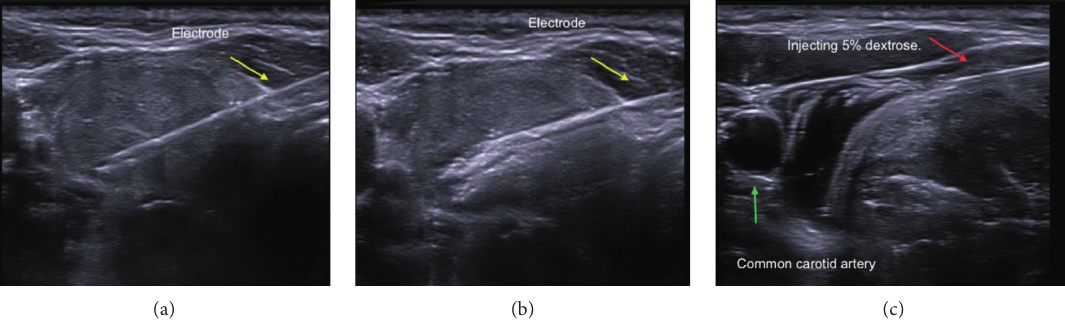
Figure 1: A 37-year-old woman presented with neck bulging. (a) Axial sonographic image shows the trans-isthmic approach of 5mm size active tip of the electrode (yellow arrow). (b) Axial sonographic image shows the moving-shot technique (yellow arrow). After ablation of the peripheral imaginary unit, the electrode is moved to the central portion and ablation is performed. (c) The hydrodissection technique was applied to preventing important structures by injecting slowly 10 ml 5% dextrose (red